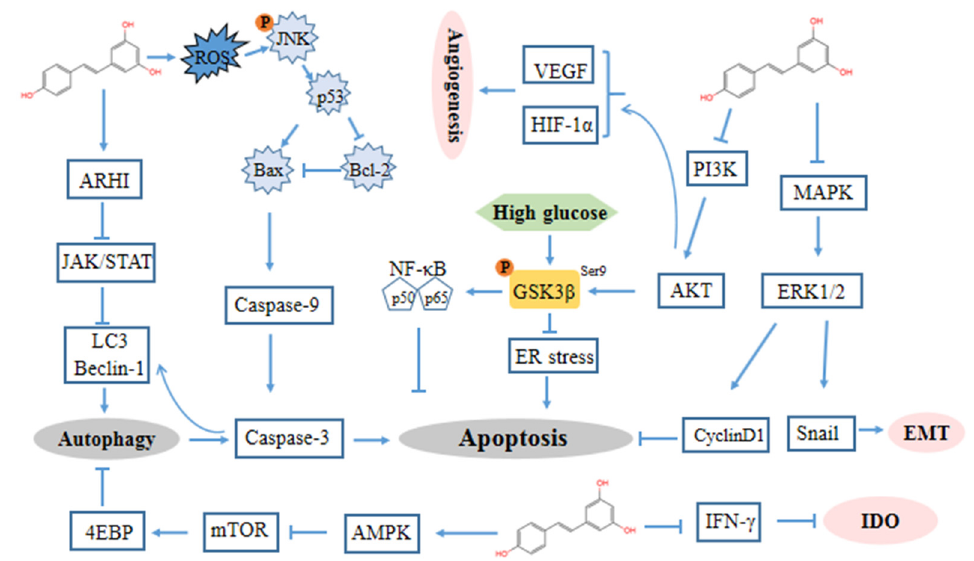
Figure 2. Mechanism of resveratrol against ovarian cancer. Extracellular signal-regulated kinase (ERK) 1/2, aplasia ras homologue member I (ARHI), AMP-activated protein kinase (AMPK), interferon- γ (IFN- γ ), Indoleamine 2, 3-dioxygenase (IDO), epithelial-to-mesenchymal transition (EMT). Zhong et al. used two human ovarian cancer cell lines, OVCAR-3 and CAOV-3, to study the inhibitory roles of resveratrol on ovarian cancer cells [85]. The results demon-